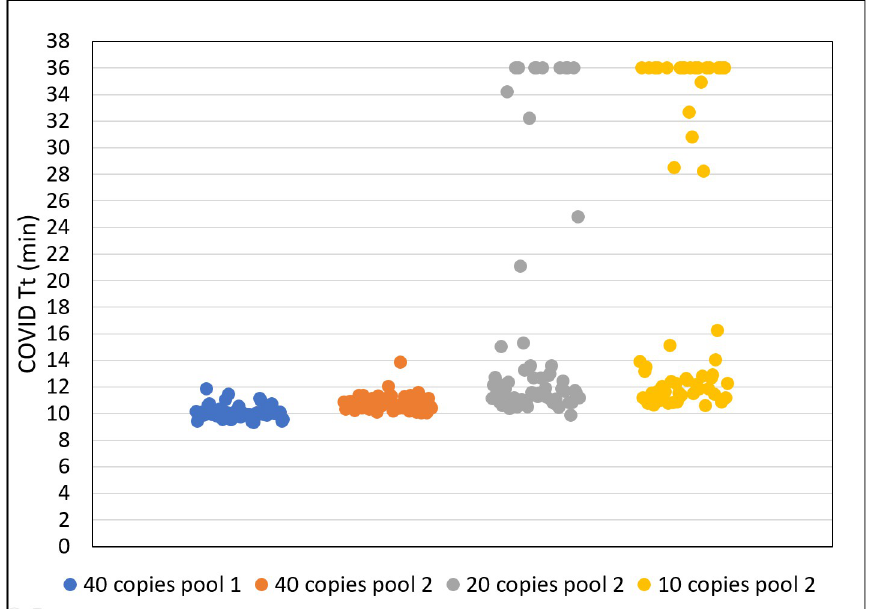
Fig 4. The limit of detection. Two saliva pools from different negative individuals (n = 10) were spiked with 10–40 copies of virus / μ L. Three LAMP reactions were performed using 20 different replicate samples. The Tt values derived from 60 reactions are plotted. No amplification is assigned a Tt value of 36 for plotting